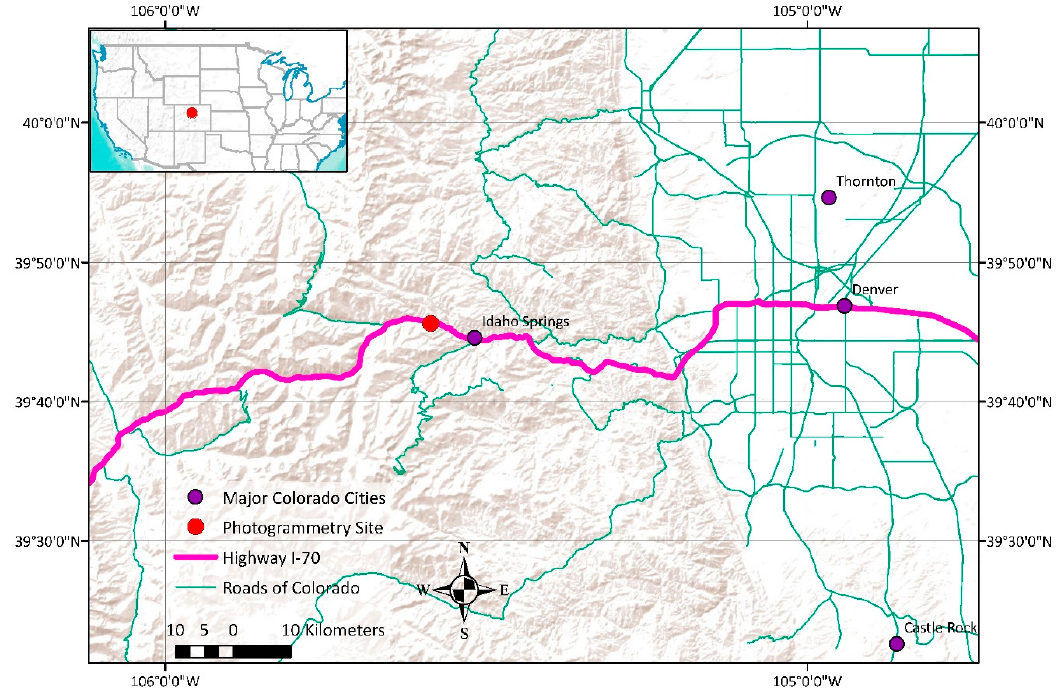
Remote Sens. 2019 , 11 , x FOR PEER REVIEW Figure 1. Site location approximately 50 km west of Denver Colorado within Clear Creek Canyon [26].